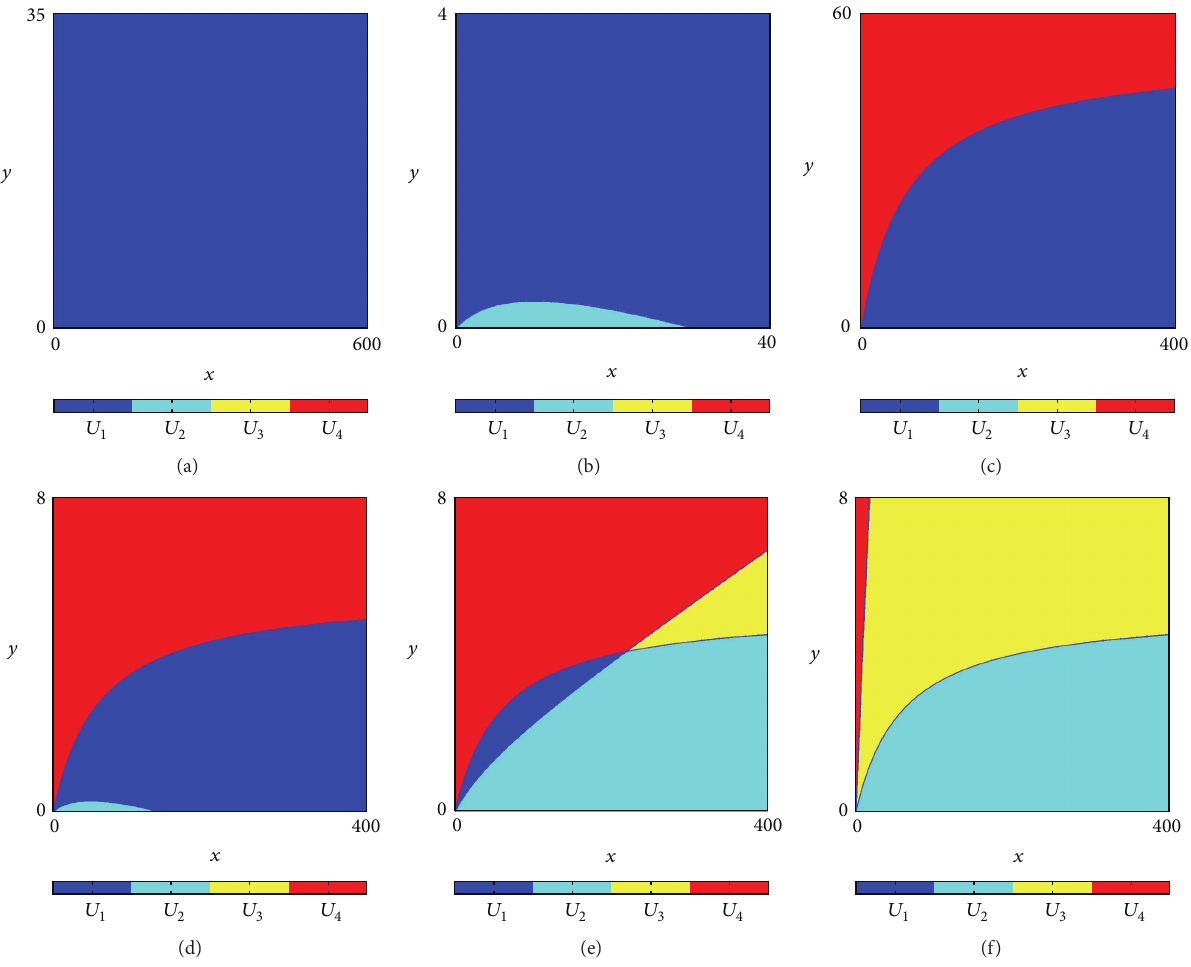
Figure 1: The phase plane is divided into several regions depending on the parameters of the model. Some situations are depicted for different parameters values: 𝑈 1 is in blue, 𝑈 2 is in light blue, 𝑈 3 is in yellow, and 𝑈 4 is in red. (a) 𝛼 = 20 , 𝛽 = 60 , 𝛿 = 14.6 , 𝜇 = 0.5 and 𝐹 = 0.4 ; (b) 𝛽 = 10 and other parameters as in (a). (c) As in CCI and INCODER [14] for fish P. mariae , 𝜇 = 0.63 , 𝐹 = 0.75 and other parameters as in (a). (d) As in CCI and INCODER [14] for fish P. magdalenae , 𝜇 = 0.897 , 𝐹 = 3.653 and other parameters as in (a). (e) 𝜇 = 1.2 and the other parameters as in (d). (f) 𝛿 = 1 and the other parameters as in (e).